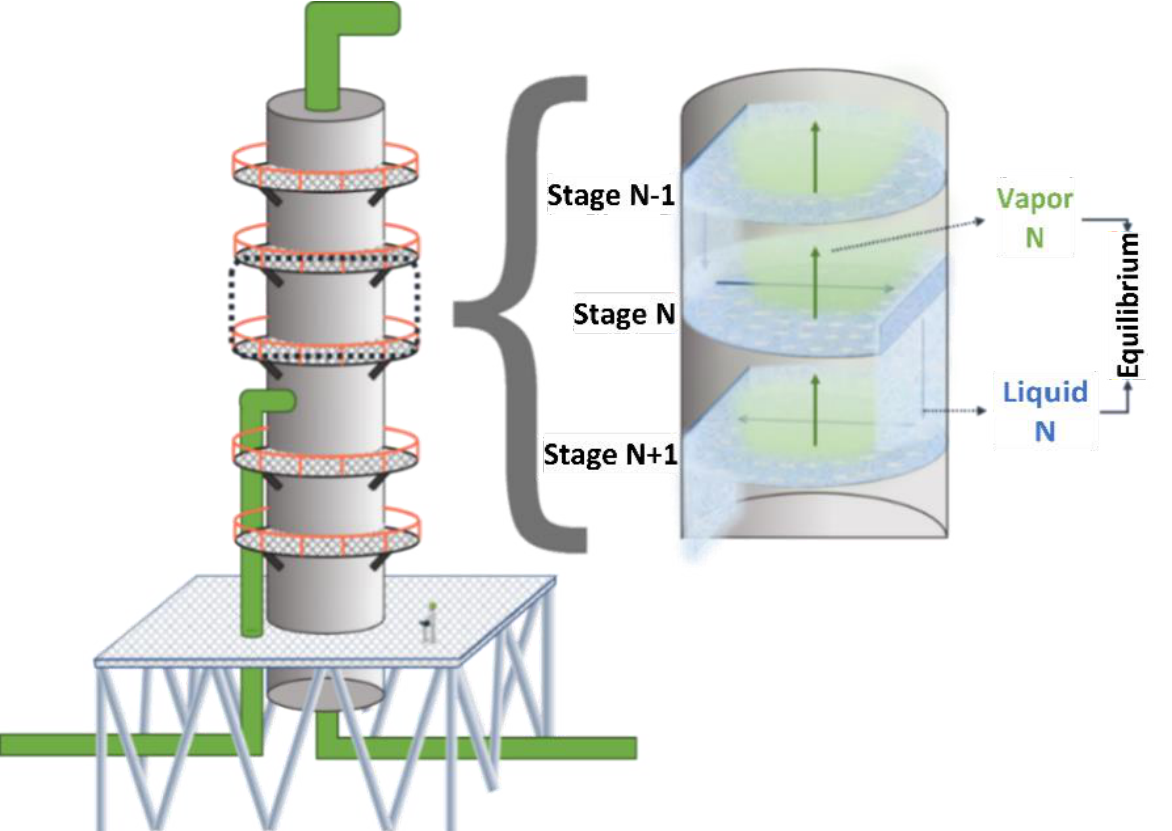
Figure 1. Distillation, an example of a unitary operation raised as a succession of equilibrium stages. Each stage is considered a VLE state, and all make up a distillation column.